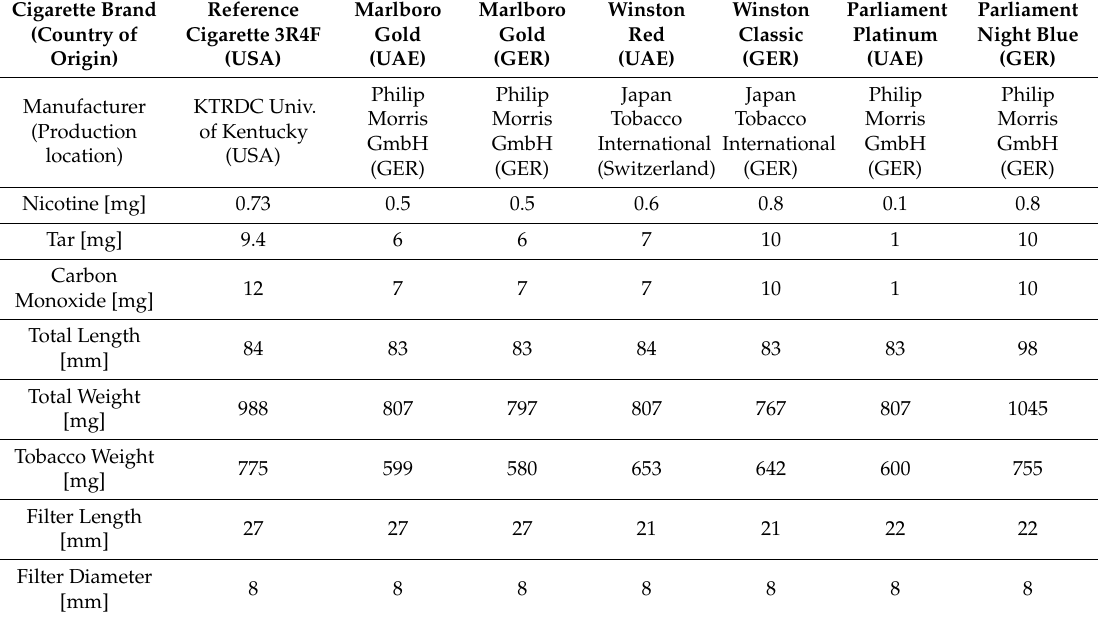
Table 1. Features of the tested cigarette brands. The cigarette dimensions and weights are the mean values of five randomized chosen cigarettes of each brand. UAE = United Arab Emirates. GER =